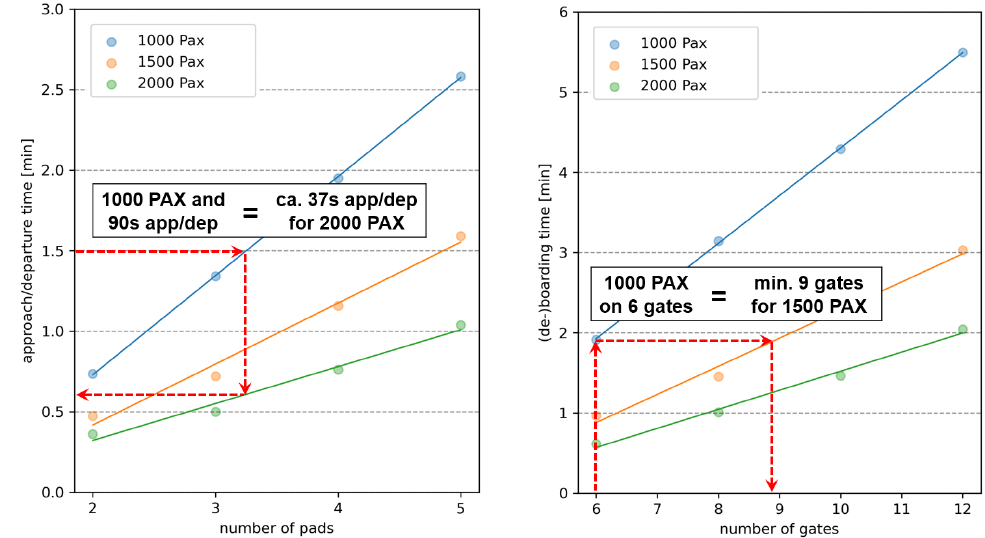
Figure A3. Application examples illustrating the use of the vertiport design